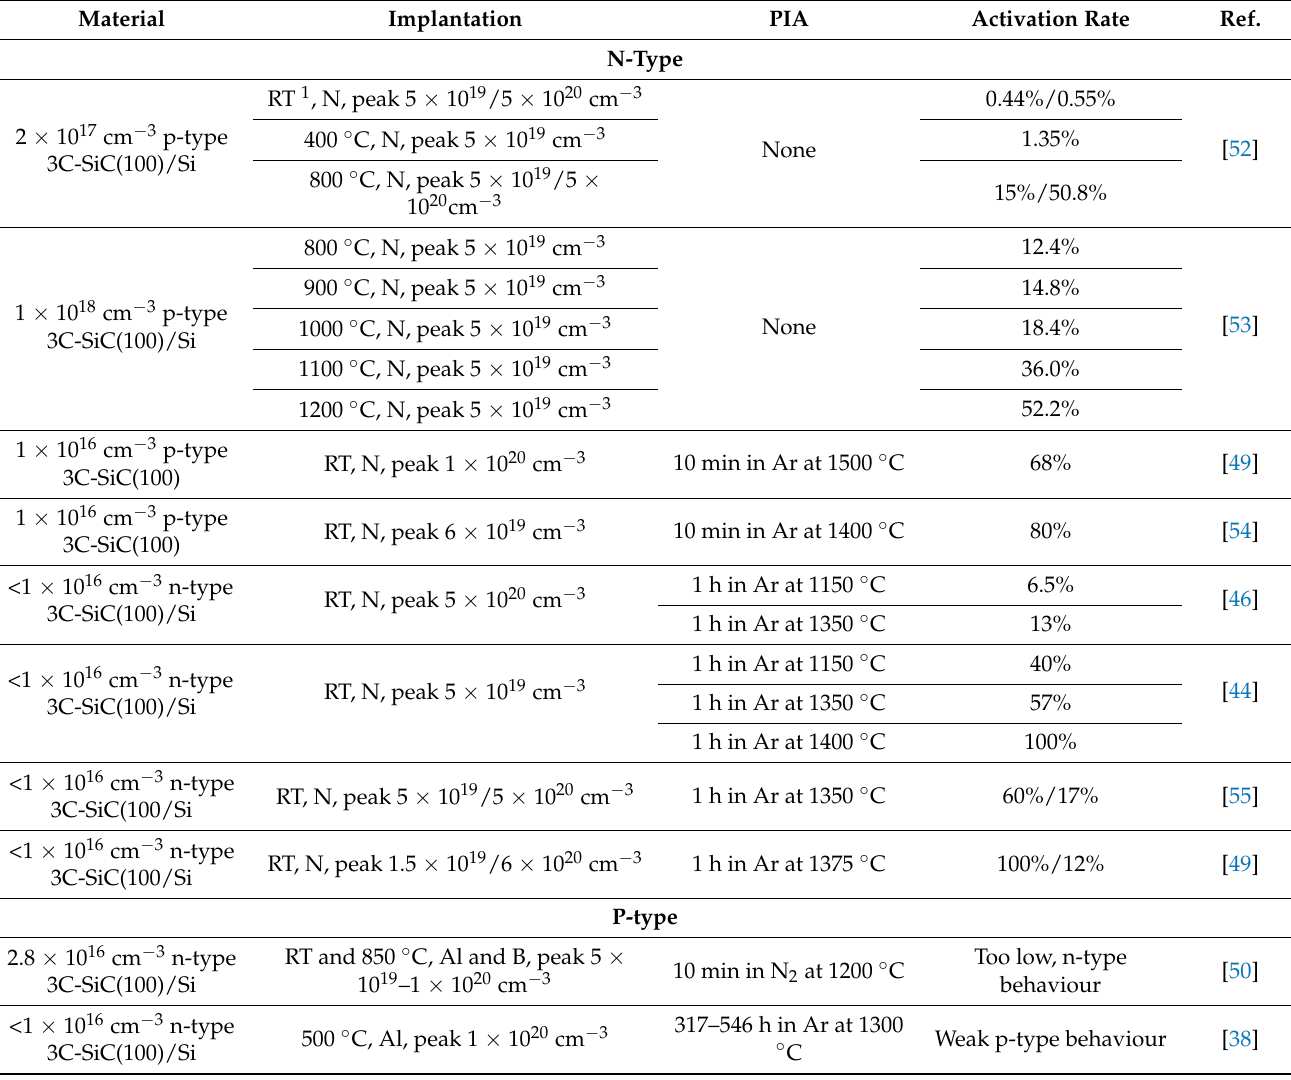
Table 3. A summary of literature data on the ion implantation and activation of